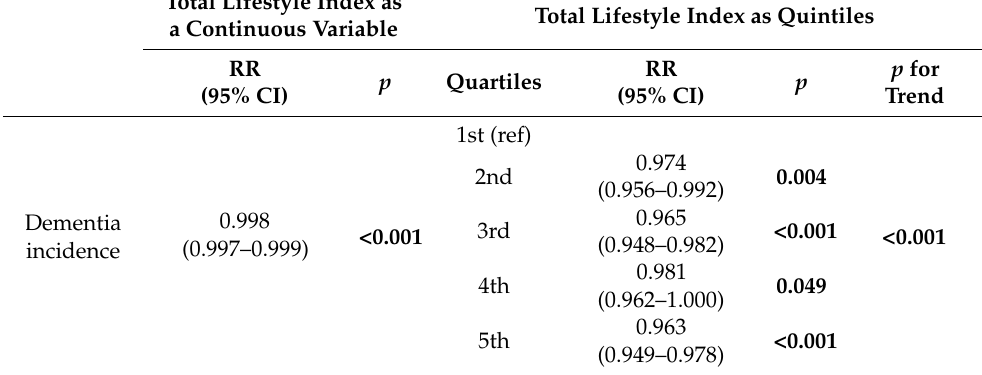
Table 3. Results from Generalized Estimating Equations that evaluated the association between Total Lifestyle Index as a continuous variable and as quintiles (independent variables) with dementia incidence (dependent variable) in non-demented participants at